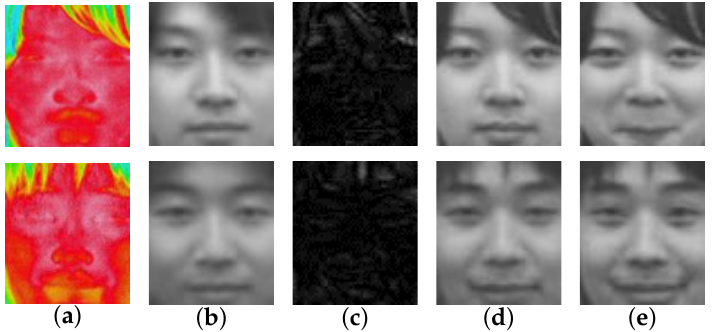
Figure 6. Visual examples in various steps of the proposed method: ( a ) thermal infrared input; ( b ) globally reconstructed images; ( c ) residual images; ( d ) fully reconstructed images; ( e ) ground-truth